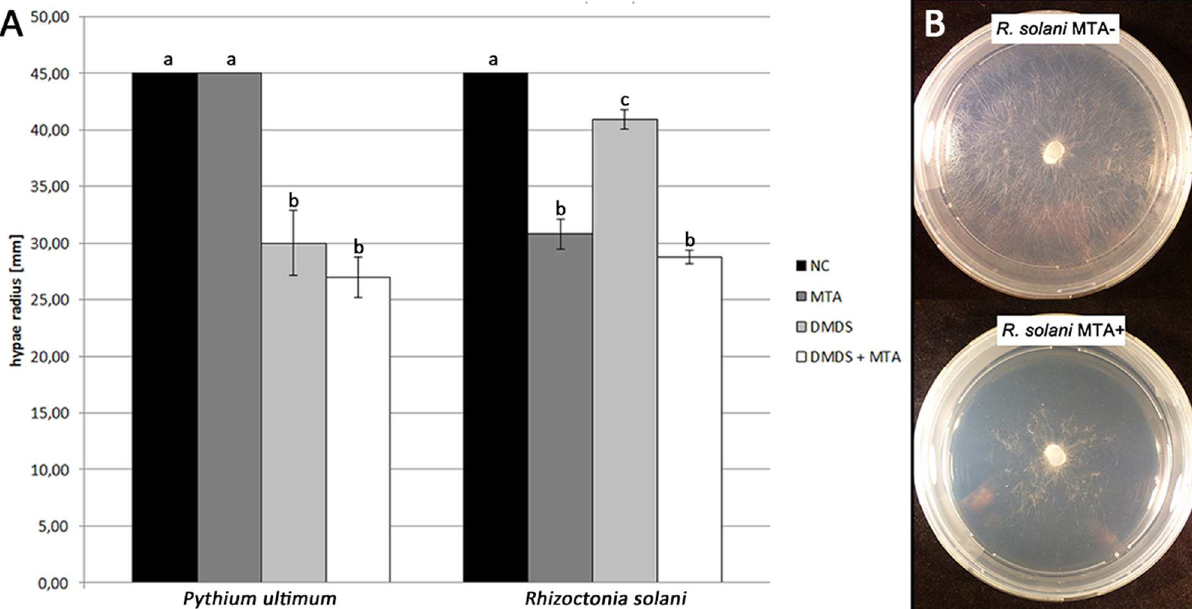
Fig 4. (A) Average hyphaeradius of P . ultimum and R . solani after 4 days of incubationexposedand not exposed(NC) to pure volatile organic compounds:S-methyl thioacetate(MTA), dimethyl disulfide(DMDS) and combination of MTA and DMDS. Significantdifference betweensamples are indicatedby different letters (one-way ANOVA, post hoc t-test p < 0.05), error bars represents standarddeviationof the mean. (B) Photos of R . solani cultures exposed (+) and not exposed(-) to MTA.